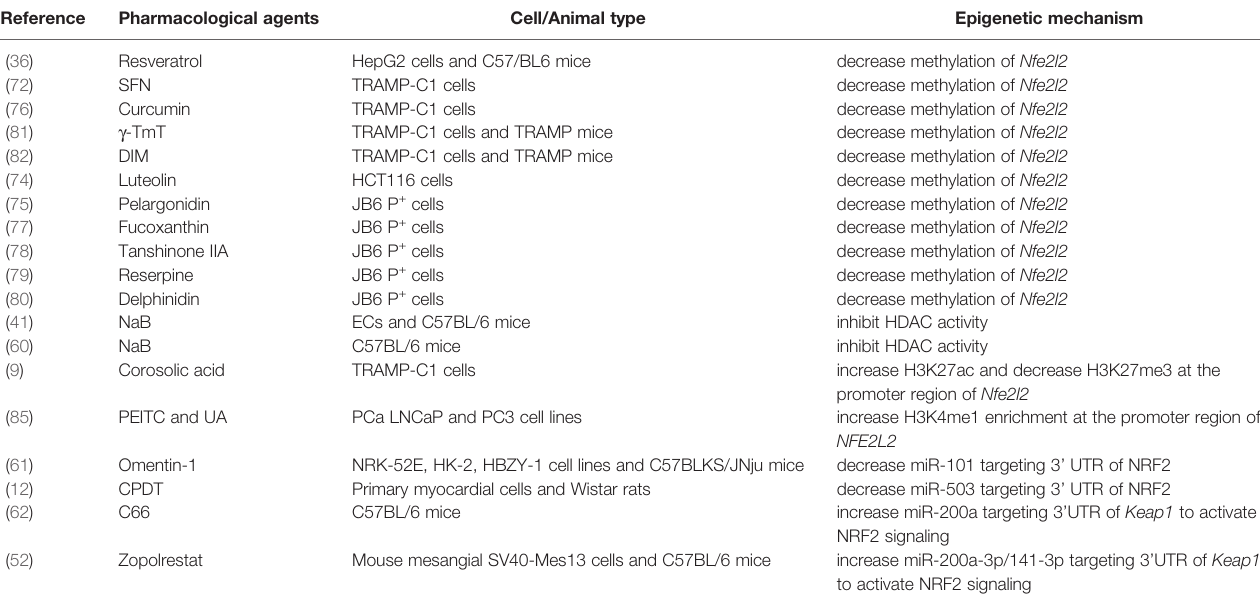
TABLE 1 | Pharmacological agents reported to regulate NRF2 signaling